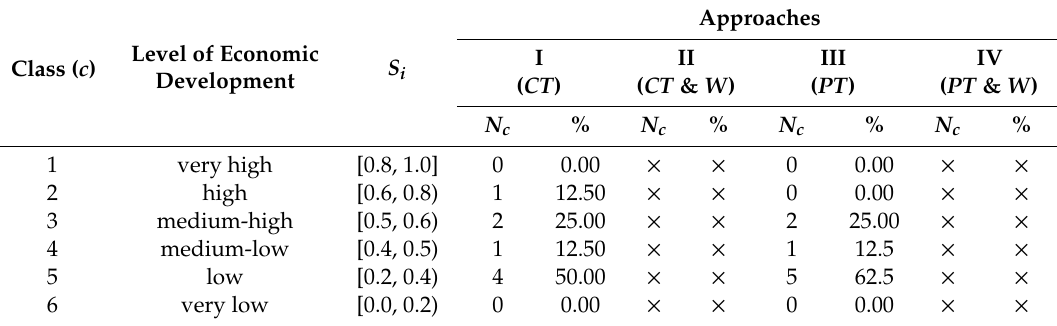
Table 7. Typological classification of districts in Poland in terms of the level of economic development at sub-regional level in